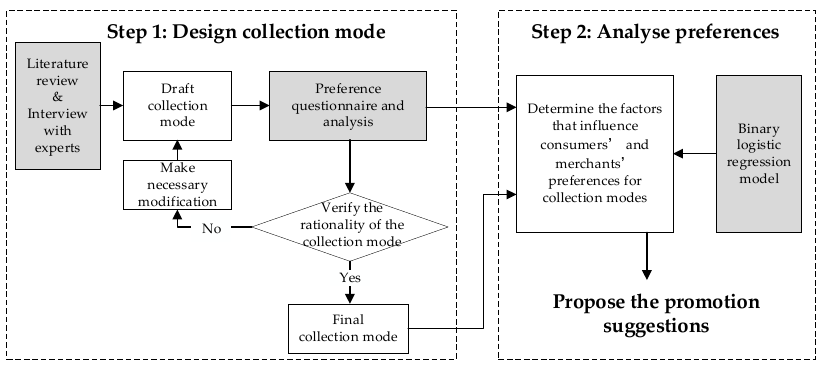
Figure 2. Flow chart of the research process.